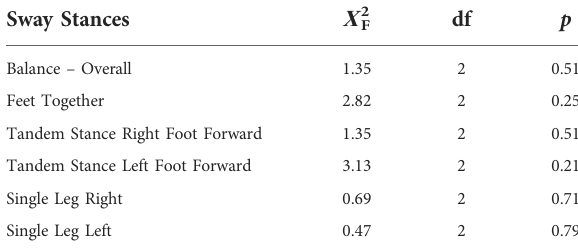
TABLE 2 Friedman ’ s ANOVA results.